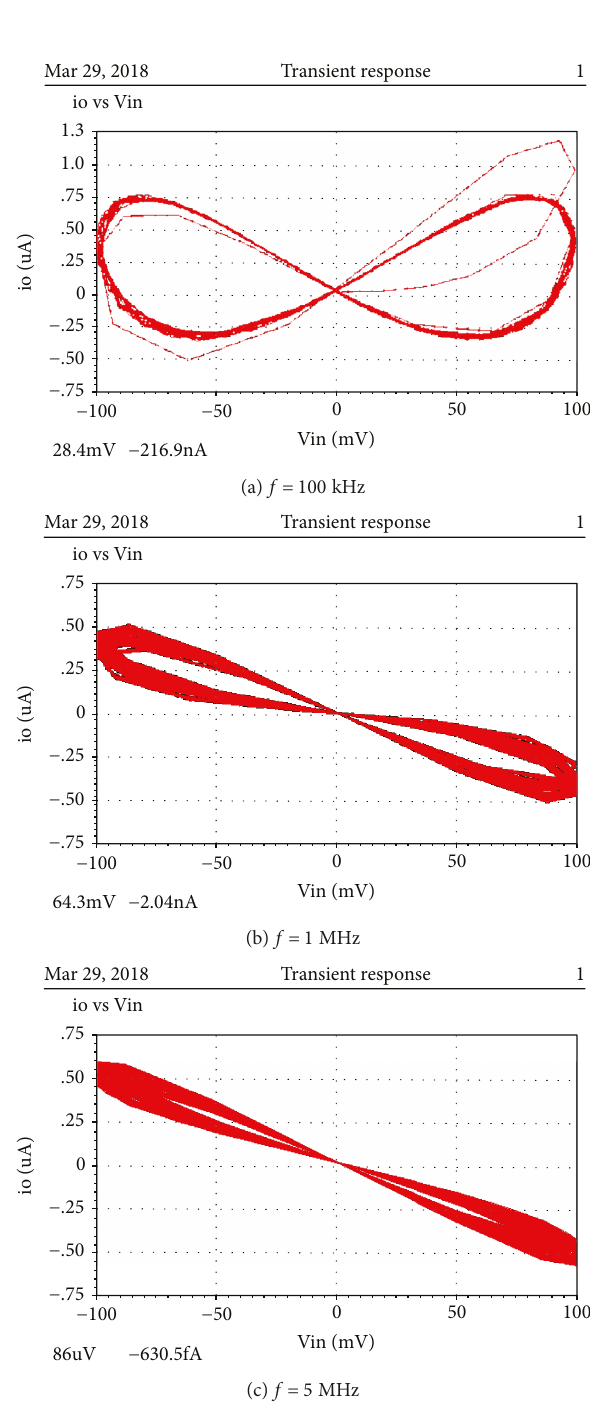
Figure 6: Cadence simulation results of the frequency-dependent pinched hysteresis loop operating at (a) 100kHz, (b) 1MHz, and (c) 5